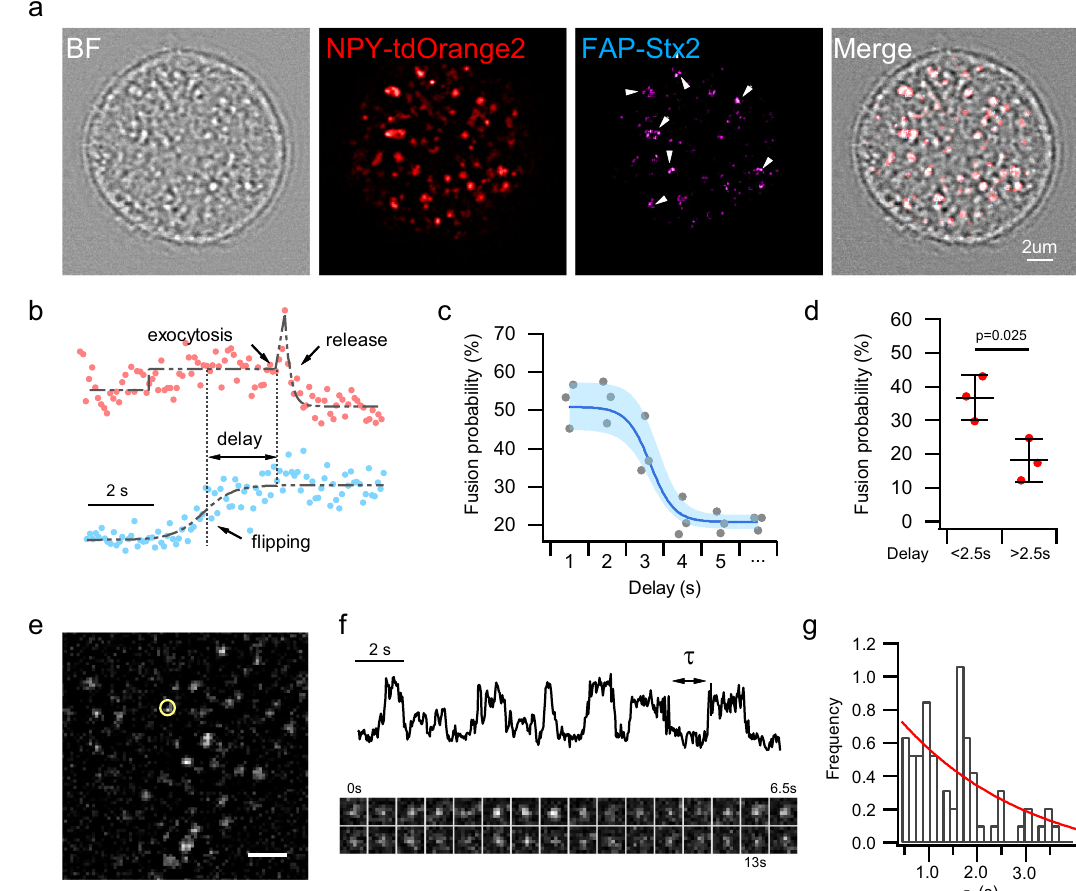
Fig. 5 | Flip-out relieves Stx2 inhibition of the fusogenic SNARE complex. a Representative images of human β -cell infected with FAP-Stx2 and NPY- tdOrange2. White arrowheads indicate sites where exocytosis and fl ipping occurs ( n =3 independent experiments). b Representative fl uorescence time course of singleFAP-Stx2 fl ippingeventsfollowedbyexocytosis,thelattercharacterizedbya transient peak increase and rapid decline. c Relationship between delay time and exocytosis probability at fusion sites. Time delay de fi ned by rising phase of Stx2 fl ippingandonsetofNPY-tdOrange2asshownin b .Symbolsdenoteaveragefusion probability measured by the proportion of predocked and newcomer granules undergoingfusionatsiteswhere fl ippingoccurring;solidlineshowsthe fi tting.The shaded areasindicate±s.e.m. The bottom axis “…” denotesdelaytime longer